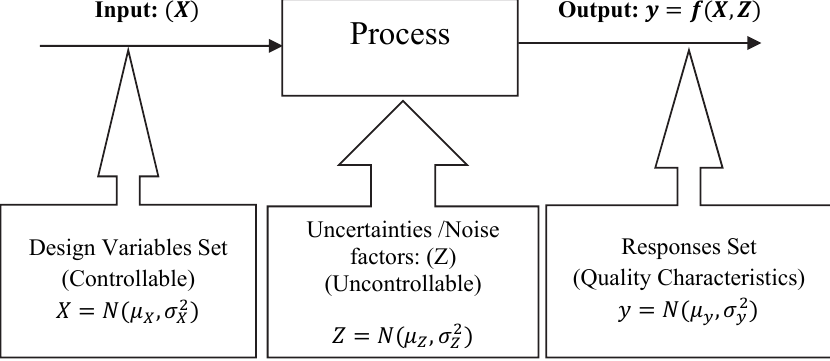
Fig. 1. An overview of process that shows Input, Output, and Uncertainties